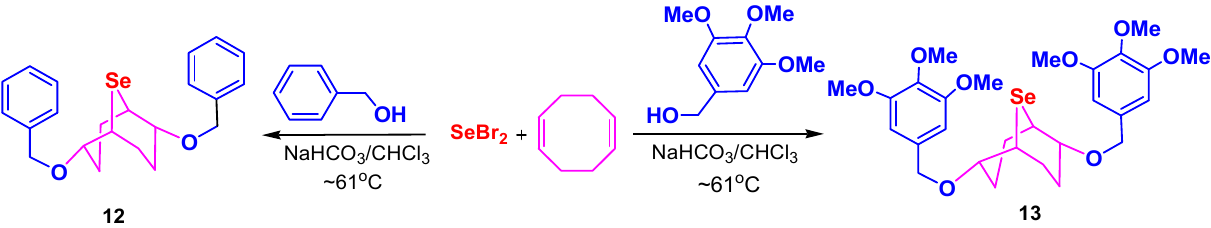
Scheme 5. The synthesis of benzyloxy derivatives 12 and 13